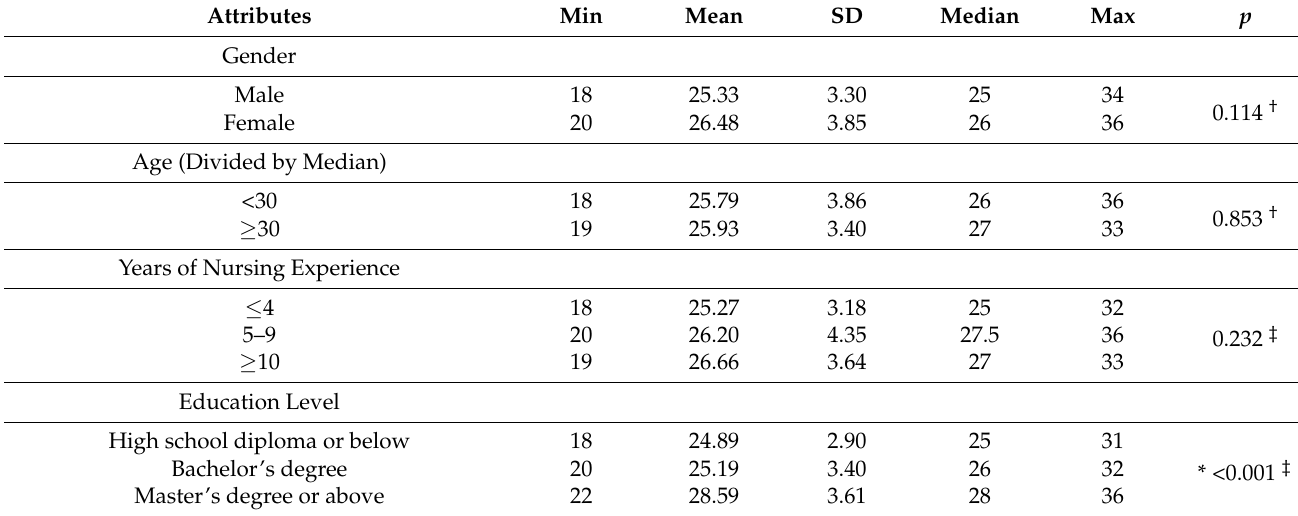
Table 7. Comparison of attitudes section according to nurses’ demographic